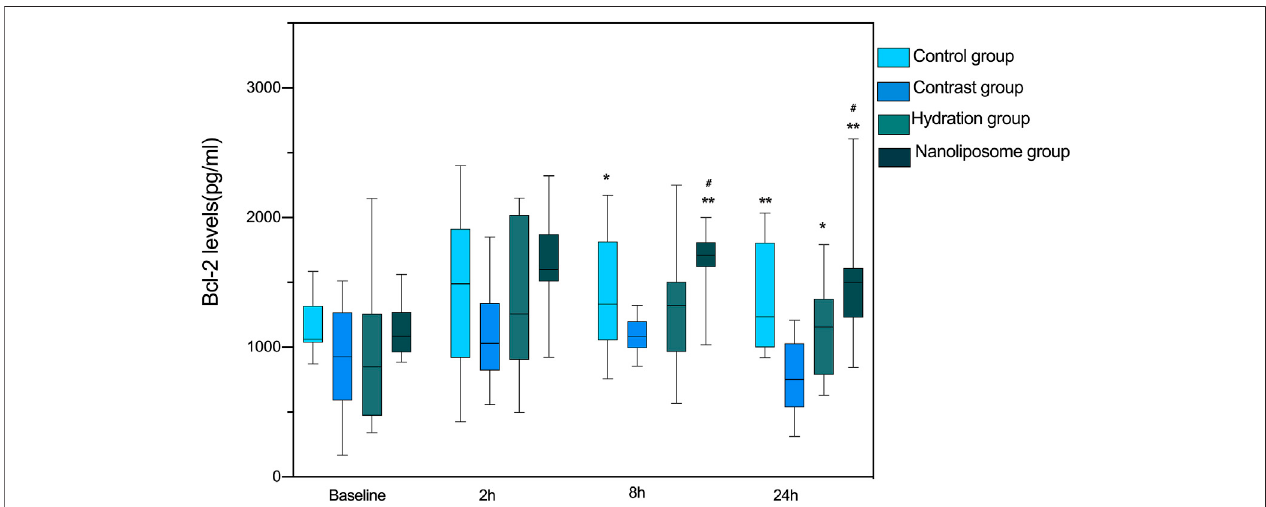
FIGURE 3 | The contents of apoptosis index Bcl-2 in four groups were detected by ELISA. Bcl-2 (cid:2) B-cell lymphoma/leukemia 2. Values are expressed as mean ± SD. *Compared with the contrast group, p < 0.05. **Compared with the contrast group, p < 0.01. # Compared with the hydration group, p < 0.05. ## Compared with the hydration group, p < 0.01.